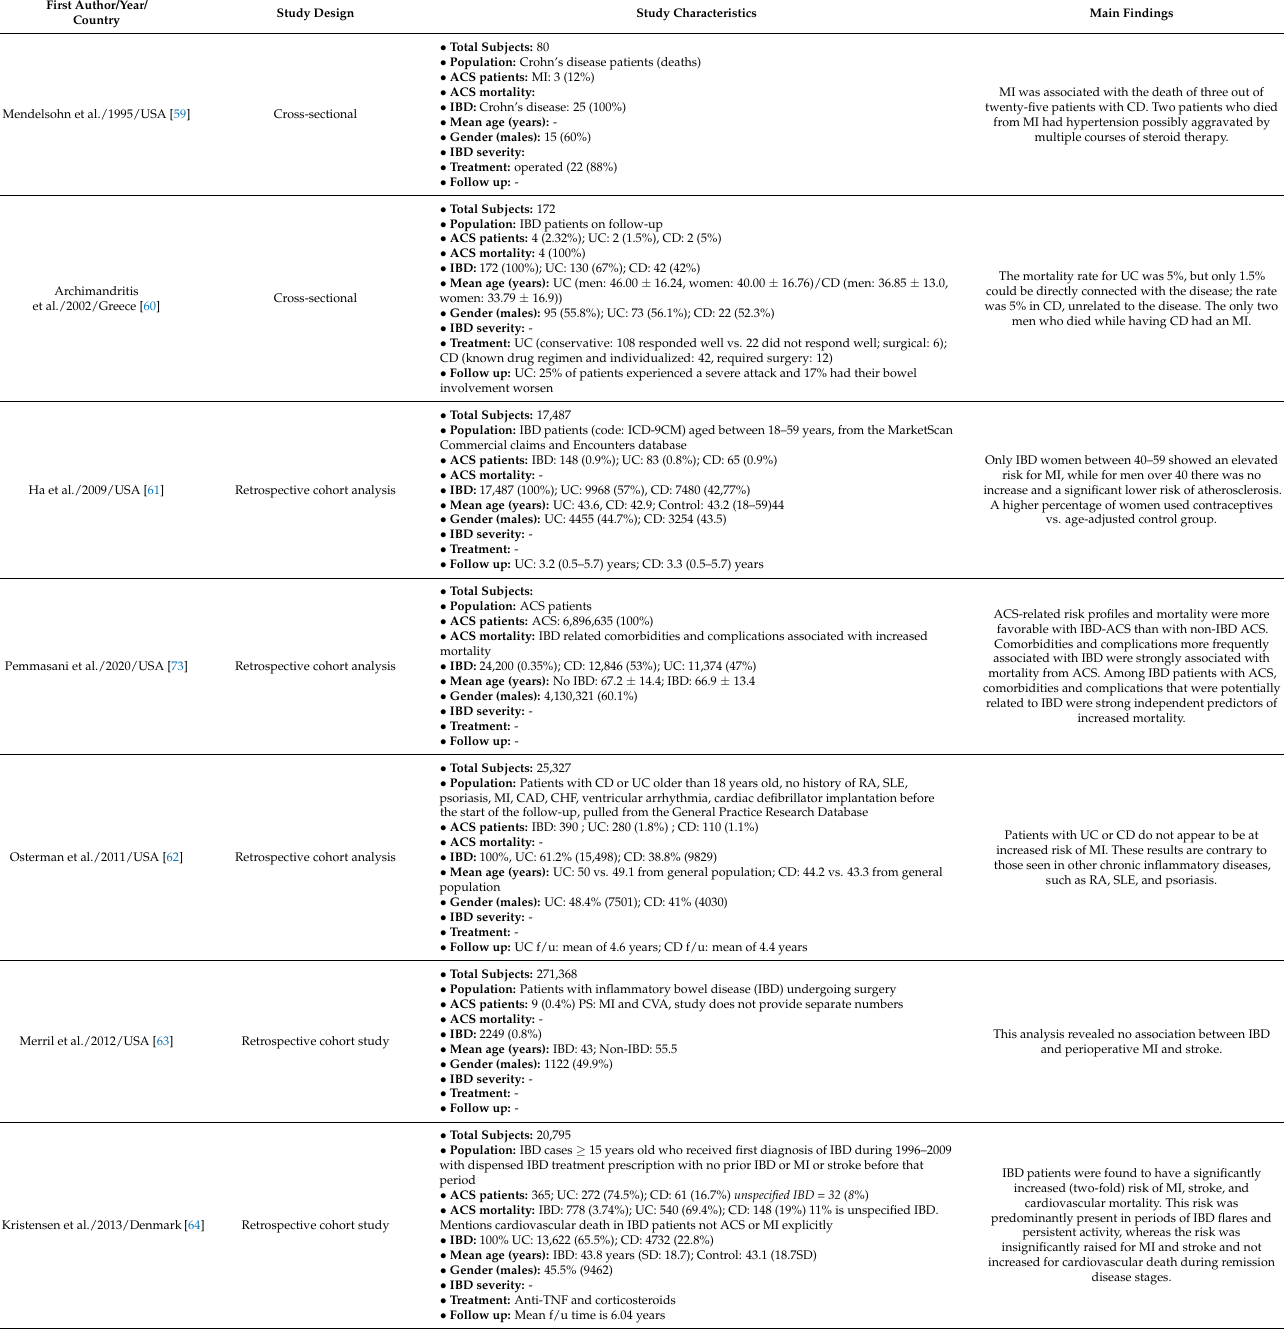
Table 1. Studies evaluating the risk of acute coronary syndromes in inflammatory bowel disease